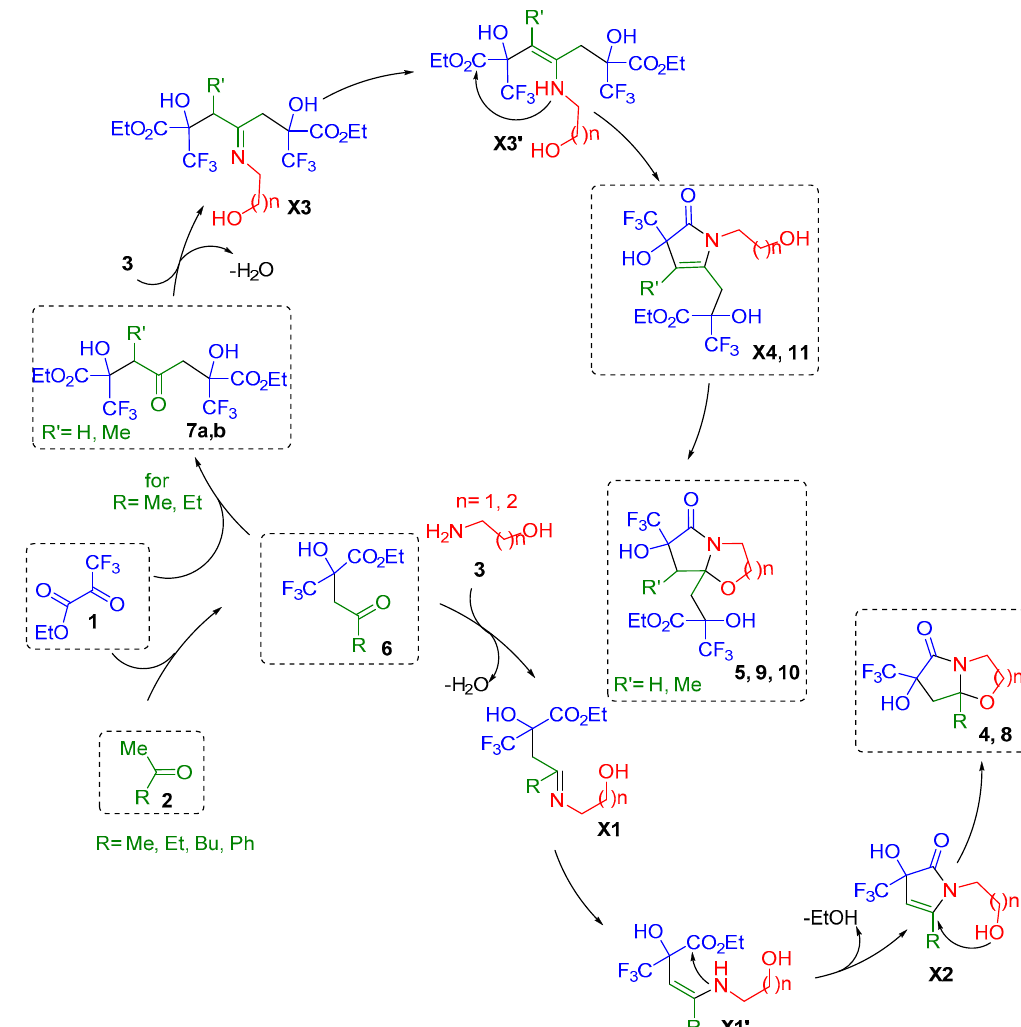
Scheme 8. Proposed mechanism of three- and four-component domino cyclization of ethyl trifluor- opyruvate 1 with methyl ketones 2a–d and amino alcohols